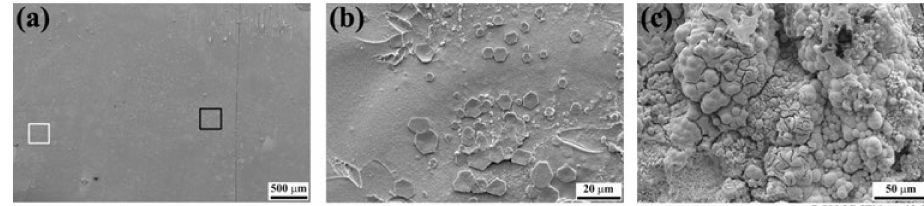
Figure 13. SEM image of the fracture surface of the SB specimen on the composite side after 28 days of accelerated aging. ( a ) Low-magnification image from the area indicated by the white arrow in Figure 11a; ( b ) high-magnification image from the black rectangle indicated in ( a ), and ( c ) high-magnification image from the white rectangle indicated in ( a ).